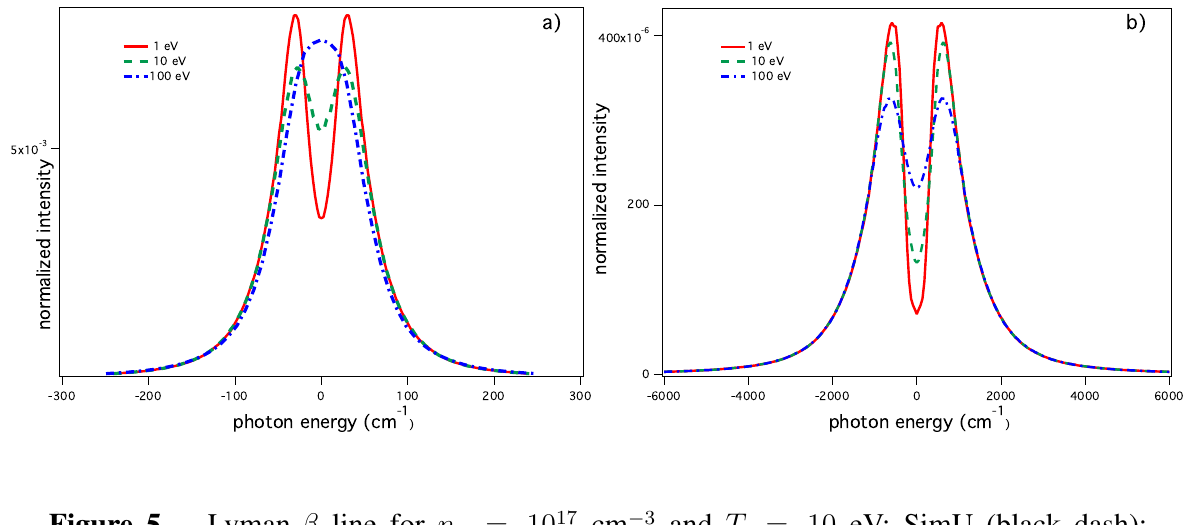
Figure 4. The ion dynamics effect on the Lyman- (cid:12) line for different values of T obtained by SimU: (solid red T = 1 eV; (green dash) T = 10 eV and (blue dot-dash) T = 100 eV = 10 17 cm (cid:0) 3 and ( b ) n = 10 19 cm (cid:0) 3 . The ideal one-component plasma at a fixed ( a ) n e e consisting of protons is assumed.